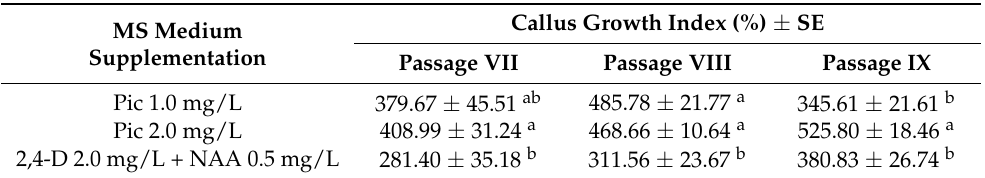
Table 7. The influence of medium supplementation on growth of callus of Linnaea borealis var. borealis during the next three passages (VII–IX).